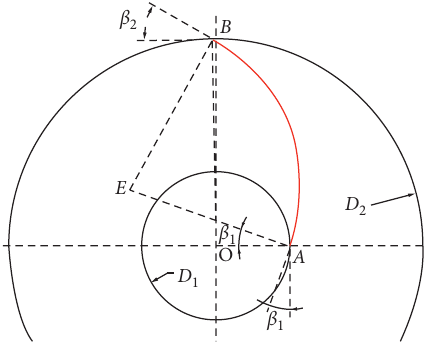
Figure 1: Blade profile of single arc